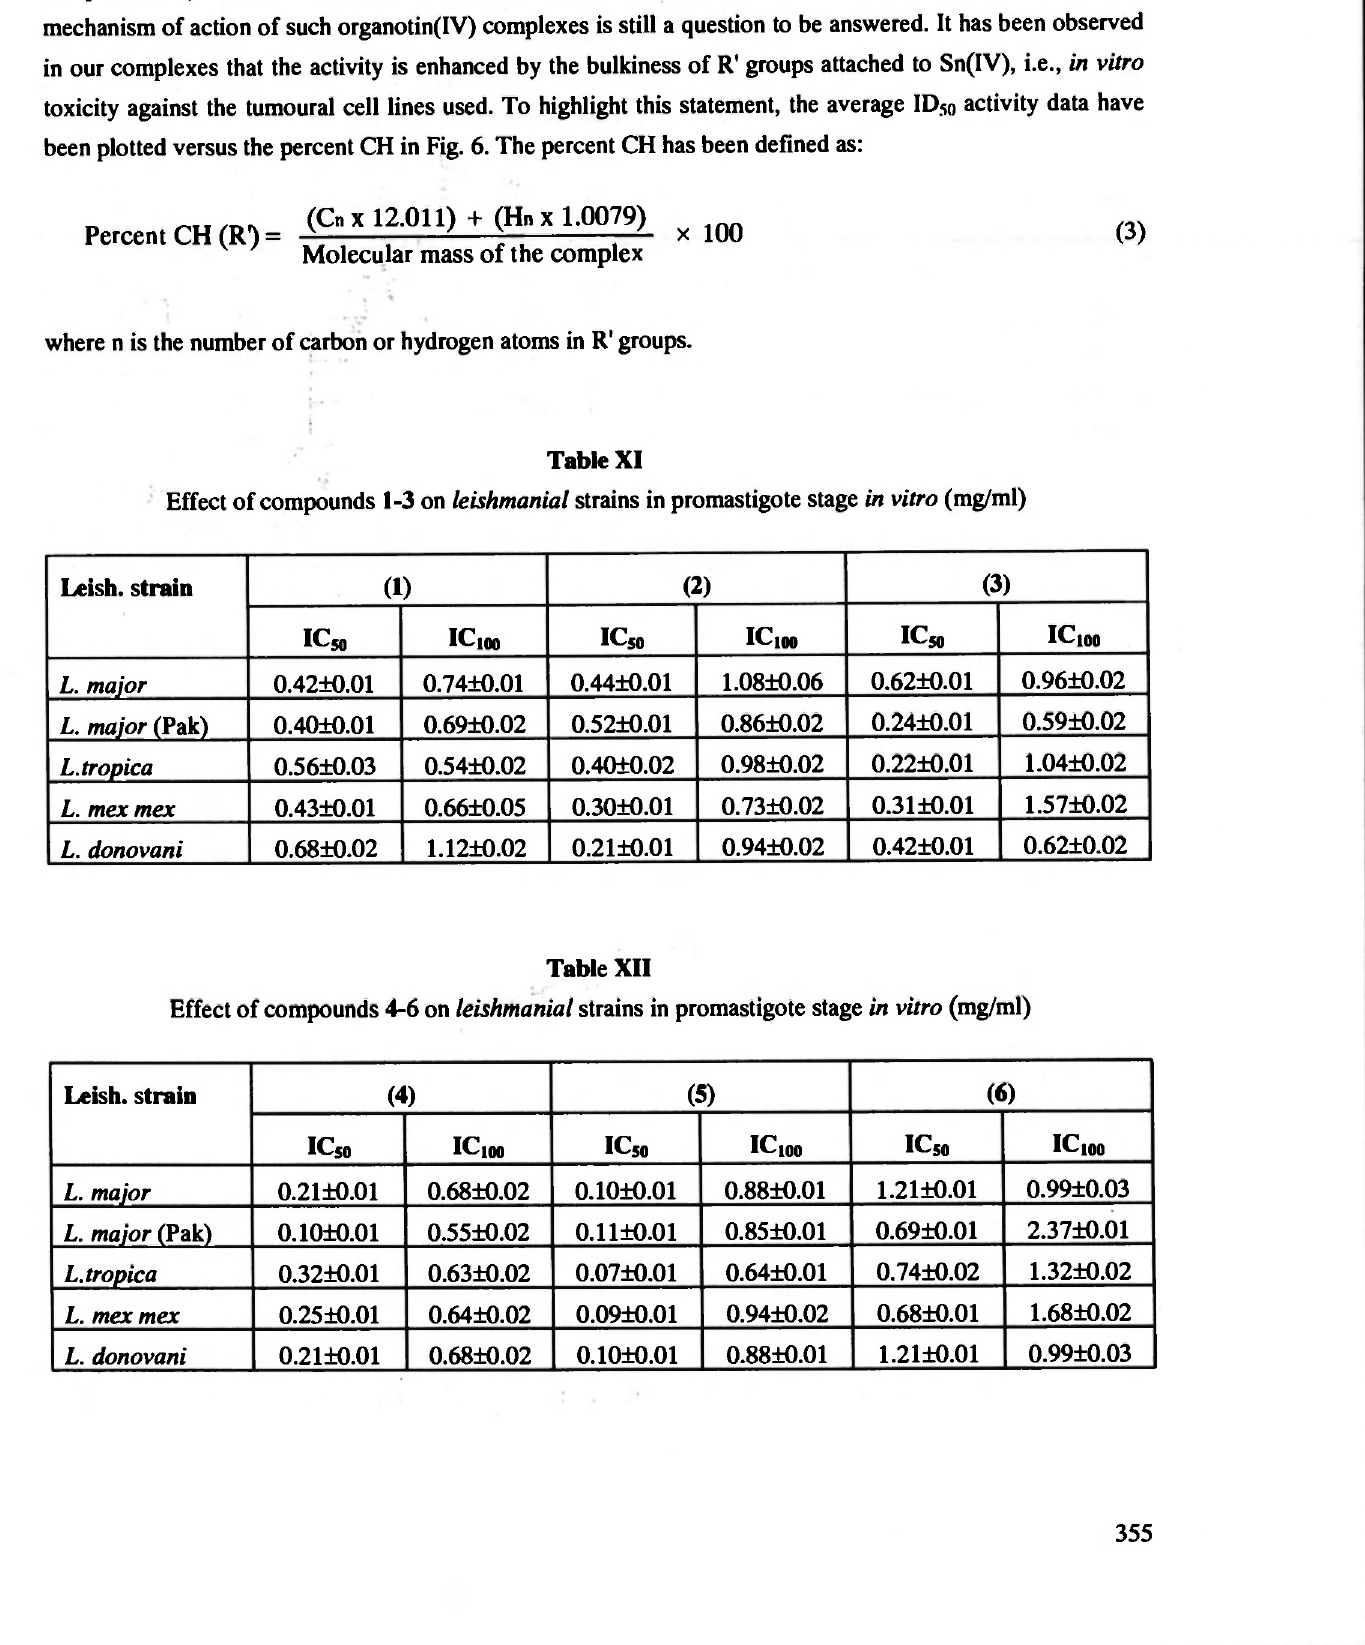
Effect of compounds 1-3 on leishmanial strains in promastigote stage in vitro (mg/ml) Leish. strain